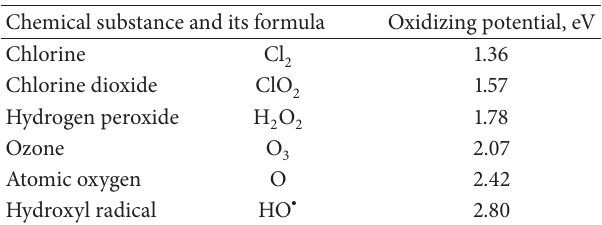
Chemical substance and its